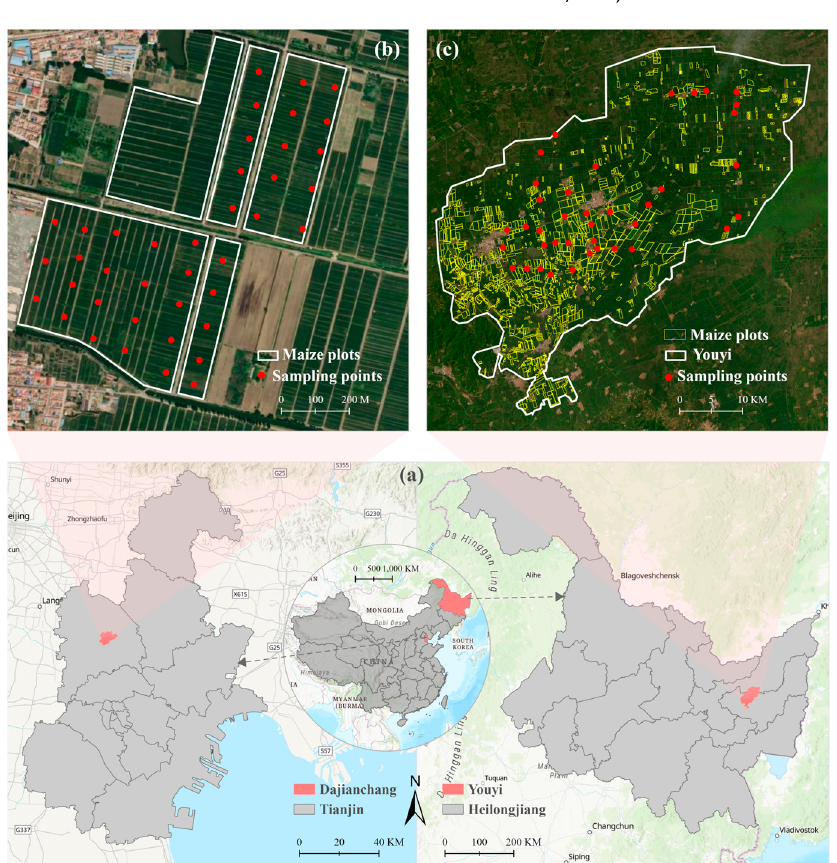
Figure 1. Location of the study area and spatial distribution of sample points: ( a ) locations of the study areas in Dajianchang Town and Youyi Farm; ( b , c ) distribution of the sample points in Dajianchang Town and Youyi Farm, respectively (the backgrounds of the maps in ( b , c ) are from Google Maps). Table 1. Statistics of the maize LCCs and CCCs obtained from Dajianchang Town and Youyi